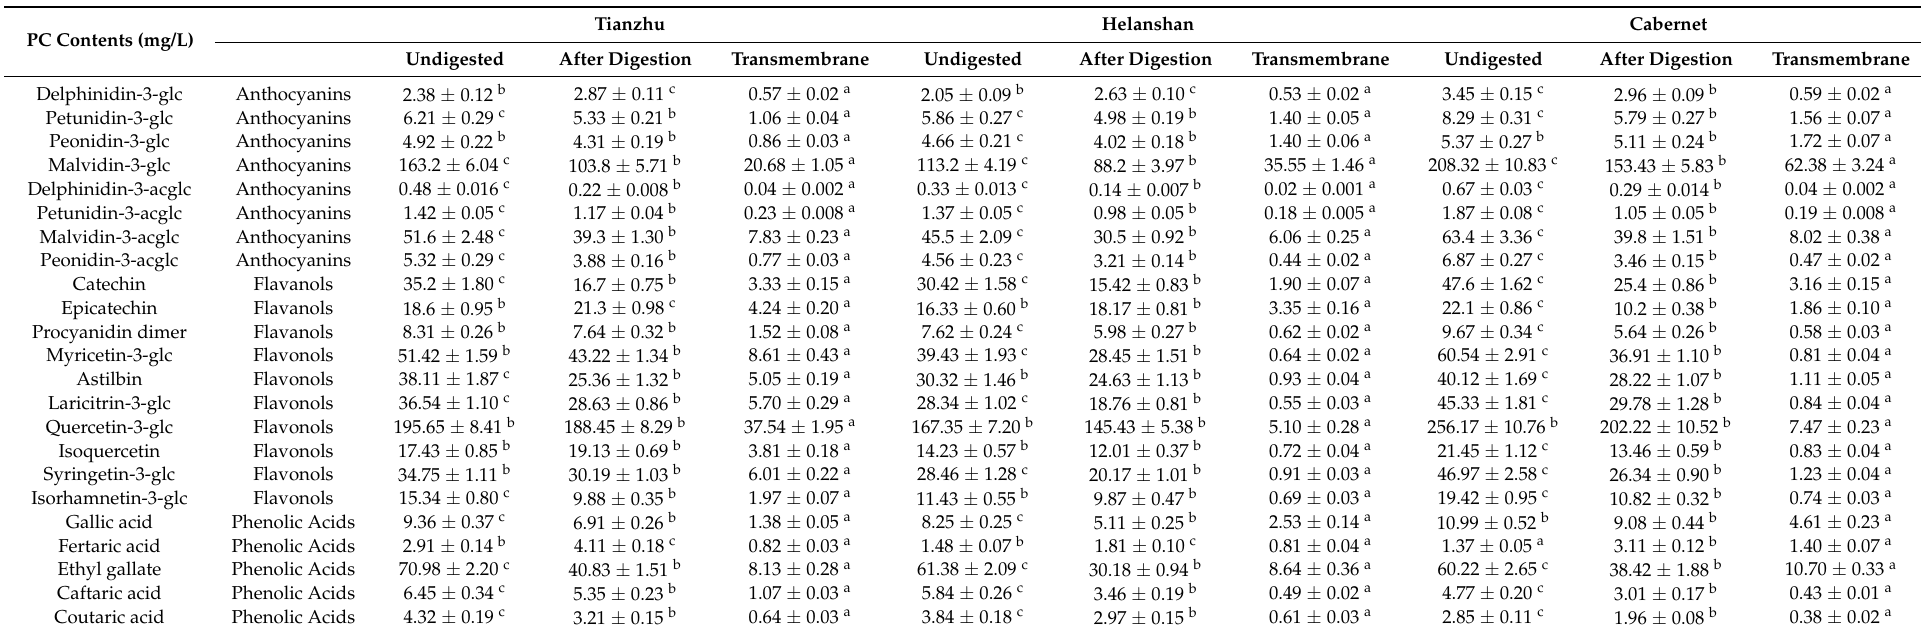
Table 1. PCs content in the red wines at different